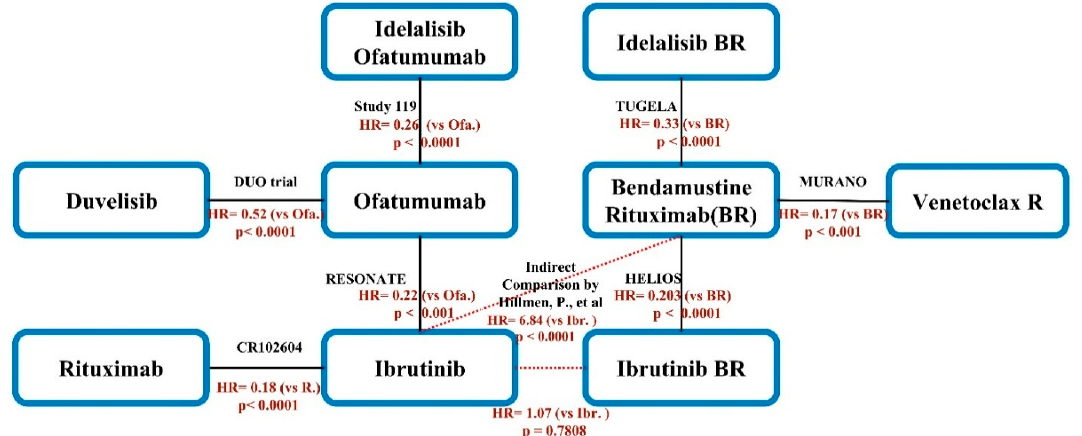
Figure 2. Schematic diagram of the network of evidence used in network meta-analysis (NMA). The black line indicates a direct comparison from RCT. The name of the trial and the published year are noted in black. The hazard ratio of PFS is noted in orange. The red dotted line indicates the individualized indirect comparison data published by Hillmen et al. HR: Hazard ratio, BR: Bendamustine + Rituximab, R: Rituximab, P: P-value